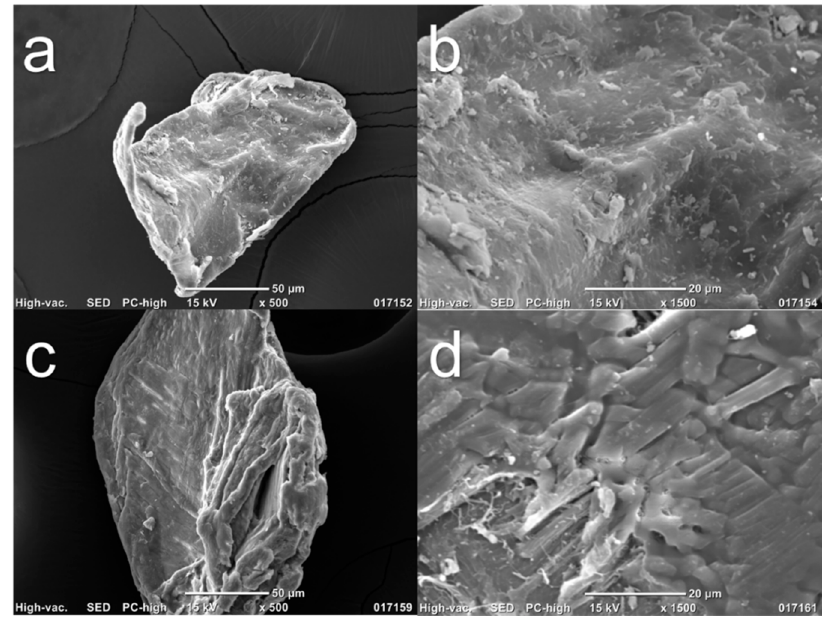
Figure 4. SEM images of chitosan flakes ( a ) and ( b ) are Chi-commercial (control) images, and ( c ) and ( d ) are Chi-2% images.